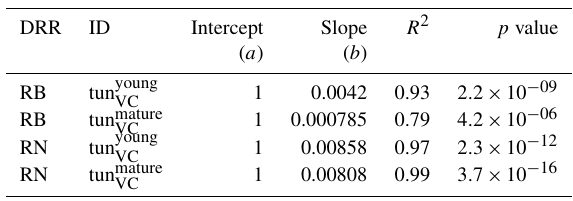
Table 3. Slopes and intercepts of biomass (RB) and NPP (RN) dose–response relationships (DRRs) for needleleaf species simu- lated by the tun VC model version (see Table 1). The fumigation of (cid:16) (cid:17) young trees tun young with O 3 is compared to the fumigation of VC mature trees (cid:0) tun mature VC